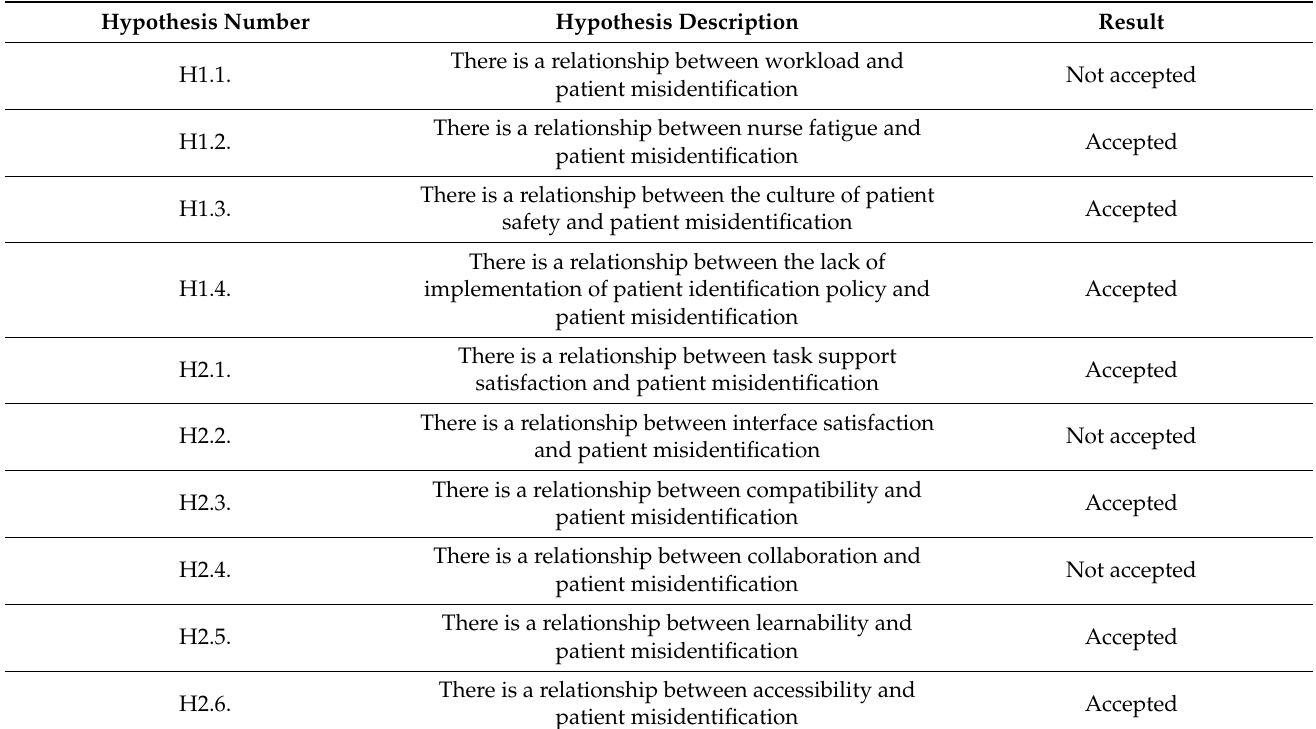
Table 14. Hypotheses